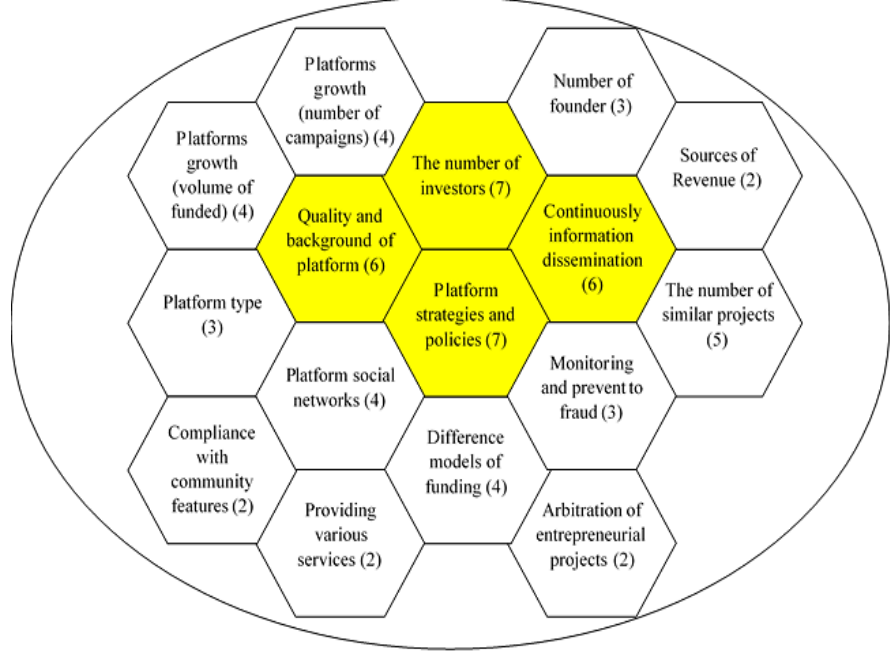
Figure 11. Clustering hexagons associated with platforms